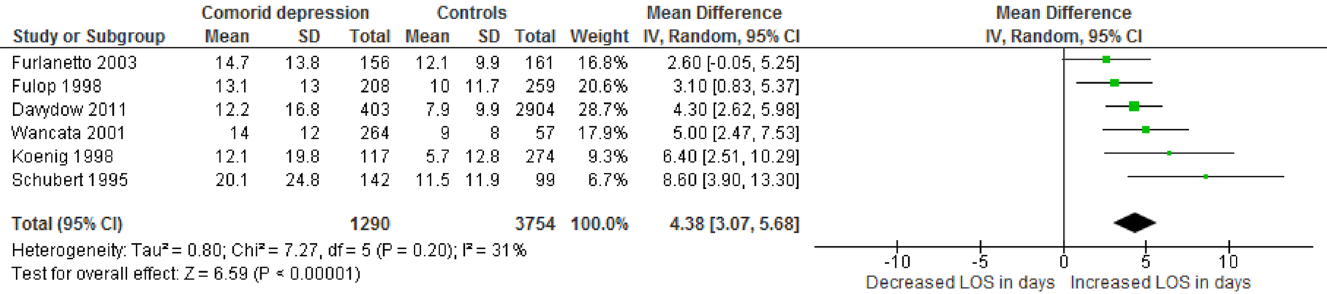
Fig 4. Meta-analysis in the subgroup depression examining the impact on length of stay (LOS).